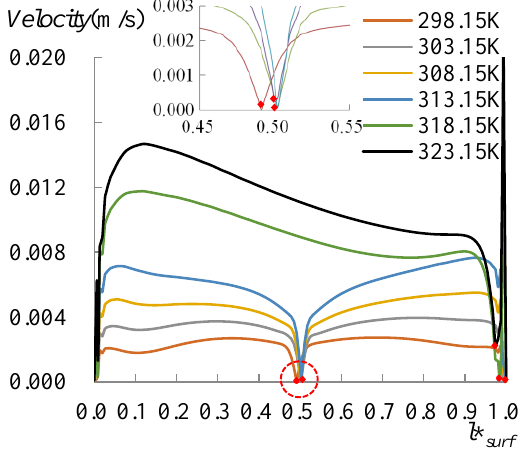
Figure 9. Velocity at the LA interface. There also exist dividing points of the velocity near the middle position of the surface length as surface temperatures when T s ≤ 313.15 K. The points moved rightward when T s = 298.15 to 303.13 K, and to the rightmost side of the droplet when T s ≥ 318.15 K.